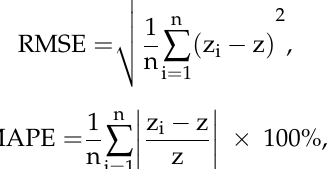
Take the field measured rice density as the real value, the Root Mean Square Errors (RMSEs) and the Mean Absolute Percent Errors (MAPEs) of rice-density estimation based on 3D point cloud and supervoxel clustering algorithm were 9.968 and 5.67%, respectively, and the average accuracy of density estimation was more than 90%. The RMSE and MAPE of rice-density estimation based on 3D point cloud and mean-shift clustering